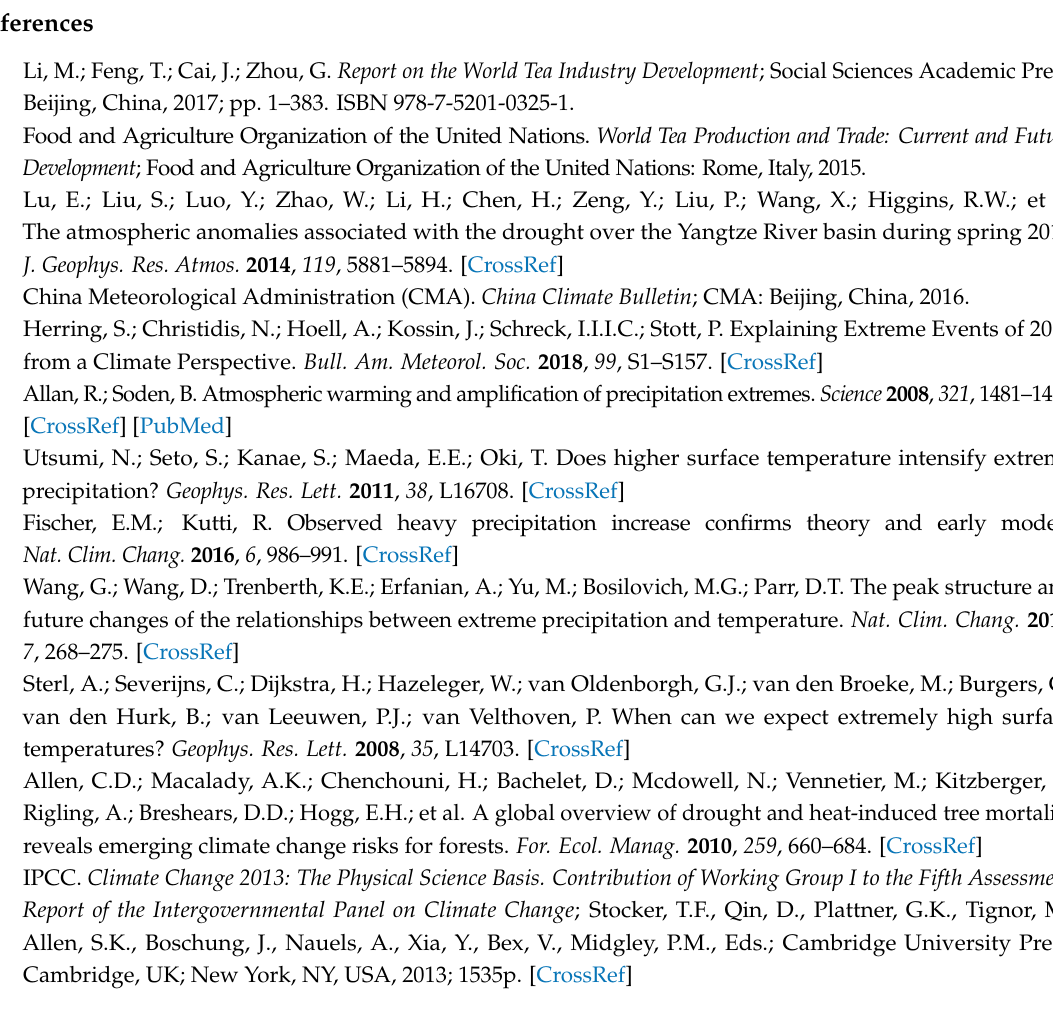
Figure S1: Data availability for the modeling study. FSDS, incident solar radiation; FLDS, incident longwave radiation; Temp, surface air temperature, Figure S2: Accelerated decomposition spinup and final spinup results for bamboo and tea plots, Figure S3: Observed and modeled daily soil water content at different depths at bamboo and tea plots, Figure S4: Observed (dots) and modeled (lines) leaf area index for Moso bamboo, Figure S5: Modeled leaf area index and various carbon pools, Figure S6: Modeled weekly carbon fluxes at the two study plots. AR, autotrophic respiration; ER, ecosystem respiration; GPP, gross primary production; NEE, net ecosystem exchange; NPP, net primary